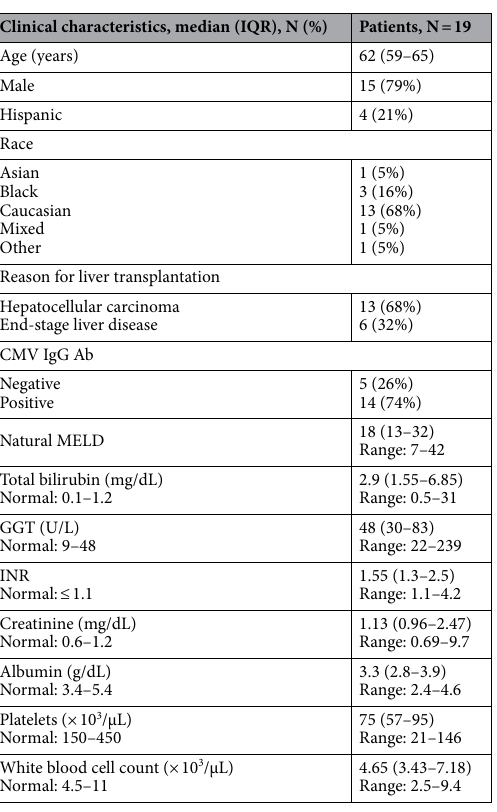
Table 1. Characteristics of the study population. IQR interquartile range, INR international normalized ratio, MELD model for end-stage liver disease, GGT gamma-glutamyl